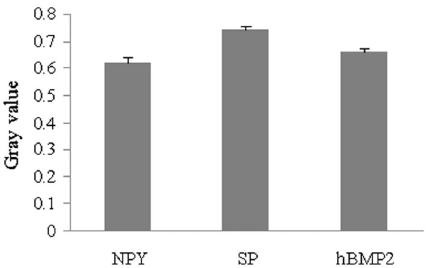
Figure 6. The expression level of neuropeptide Y (NPY), substance P (SP) and human bone morphogenetic protein 2 (hBMP2) receptors. The graph indicates the gray values of human osteoblasts, as measured with immunocytochemical assays. The expression level of the receptor was inversely associated with the gray value of the staining cell and positively associated with the antigen level of the cell. Therefore, the expression was the highest for NPY receptor and the lowest for SP receptor in human osteoblasts.